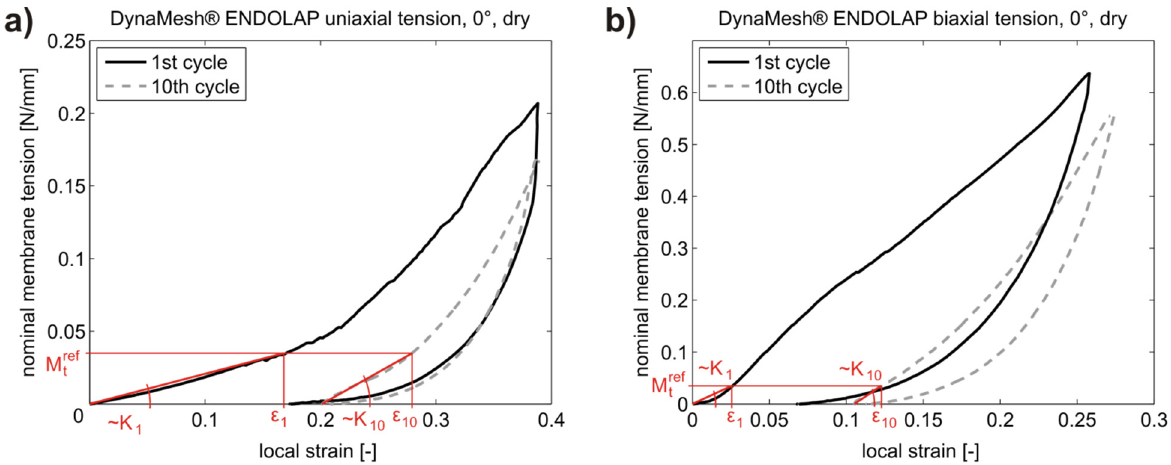
Figure 1. Exemplary tension-strain curves for DynaMesh ENDOLAP (DM) for the illustration of secant stiffness determination. ( a ) Uniaxial tension in the 0° direction, dry mesh, loading and unloading in 1st and 10th cycle; ( b ) Biaxial tension in the 0° direction, dry mesh, loading and unloading in 1st and 10th cycle. Secant stiffness in the 1st and 10th cycle is shown for